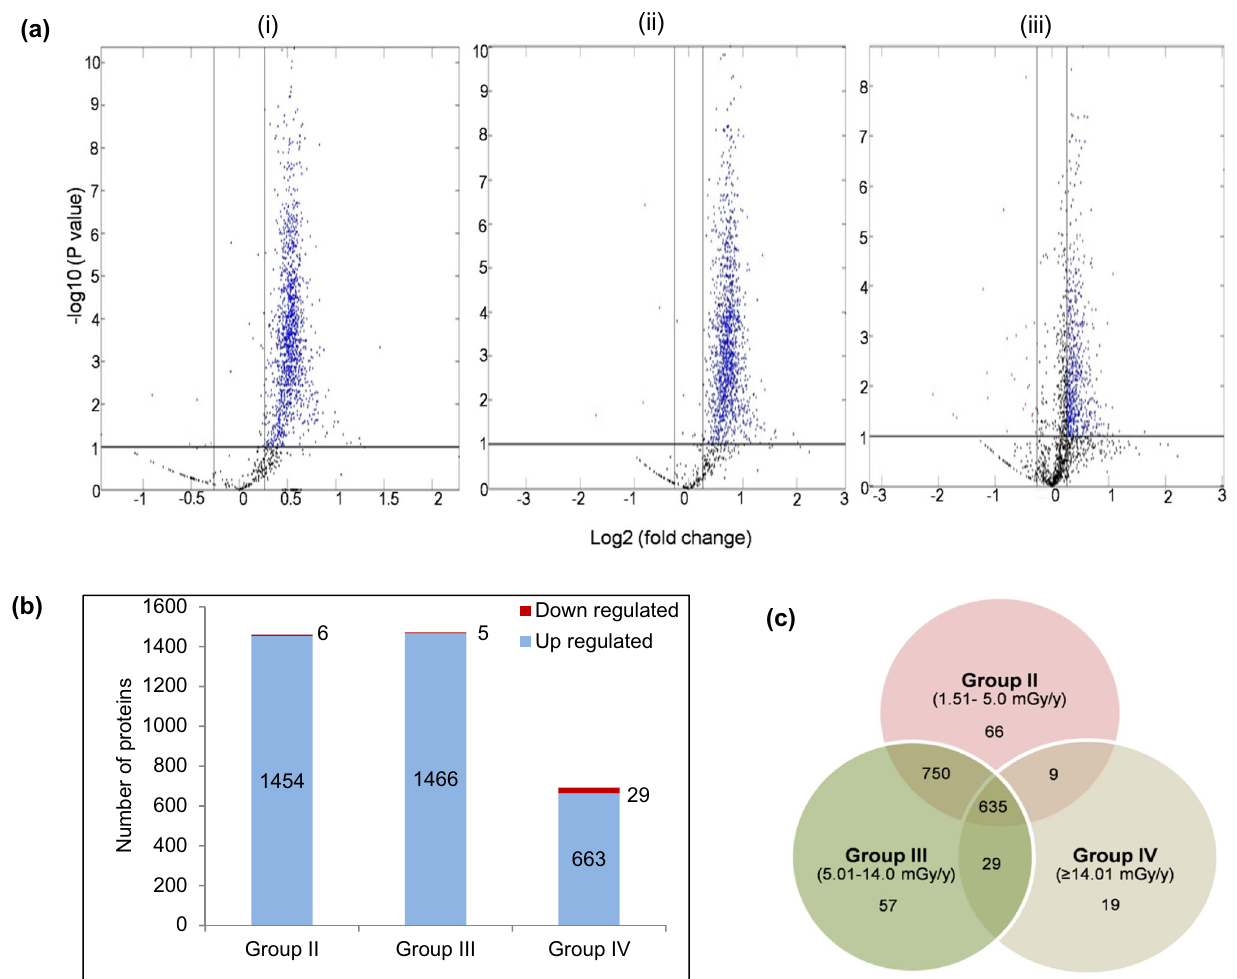
Figure 1. Quantitative iTRAQ based LC–MS/MS analysis of human PBMCs from individuals residing in HLNRA. ( a ). Volcano plots showing adjusted P values (− log10) versus protein ratio (log2) for (i) Group II (ii) Group III (iii) Group IV HLNRA dose groups. Blue dots represent significant up-regulated genes (iTRAQ ratio ≥ 1.2, adjusted P < 0.1) and red dots represent significant down-regulated genes (iTRAQ ratio ≤ 0.83, adjusted P < 0.1). Protein dots represented in black were not differentially altered. ( b ). Number of differentially regulated proteins in the three HLNRA dose groups. The numbers on the graph show up-(blue) and down-(red) regulated proteins. ( c ). Venn diagram of unique and overlapping differentially regulated proteins in the three HLNRA dose